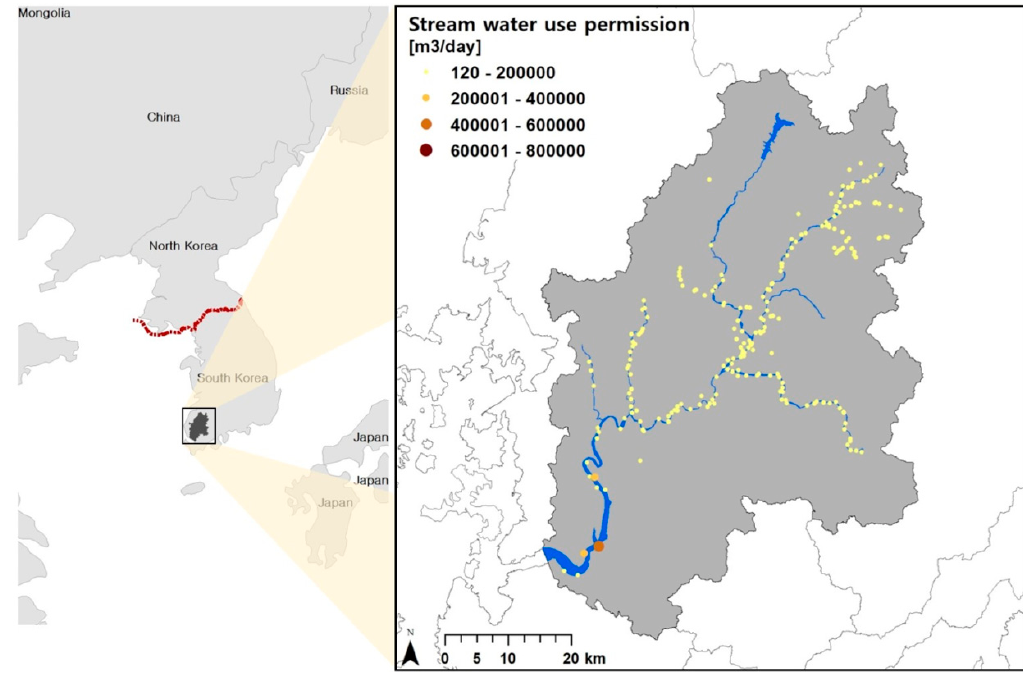
Figure 2. Location of Yeongsan River basin with the stream water-use facilities.